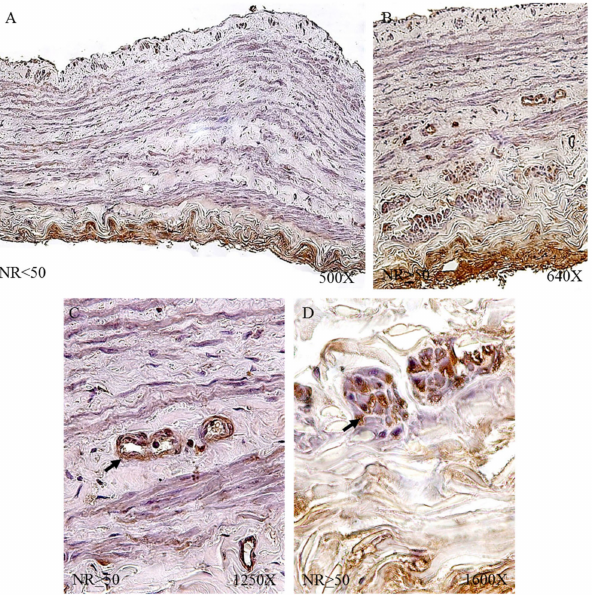
Figure 7. Images showing tropoelastin protein expression in patients with NR < 50 ( A ) and NR > 50 ( B – D ).